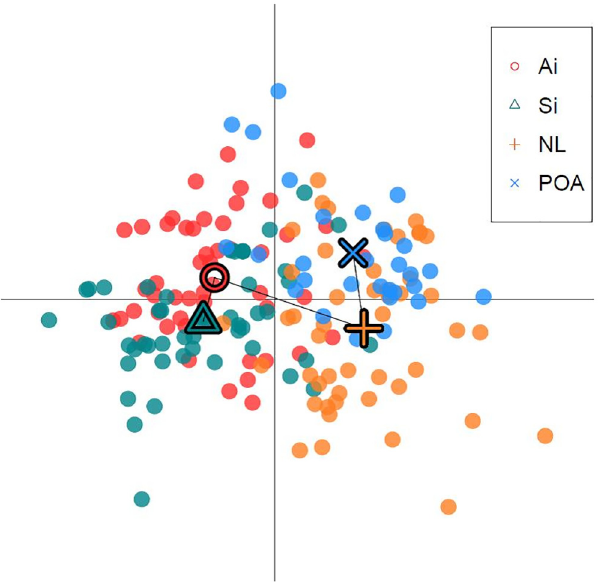
Fig 5. Plot of the DAPC analysis for groups defined by sampling location. Dots represent individuals and the centre of the population indicated by a corresponding shape, connected by a minimum spanning tree